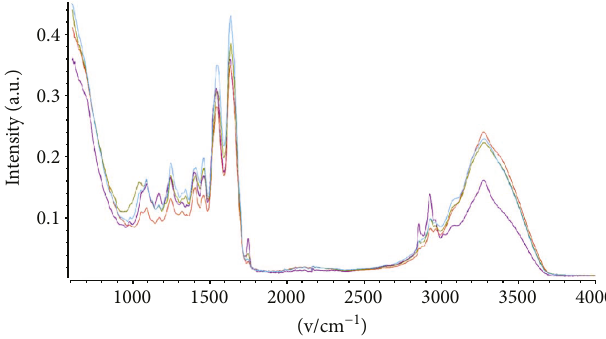
Figure 5: FT-IR spectral comparison of the di ff erent fresh salmon components. Brown spectrum belongs to salmon muscle, red spectrum to fat, and dark and light green to the outer and inner skin surfaces, respectively.